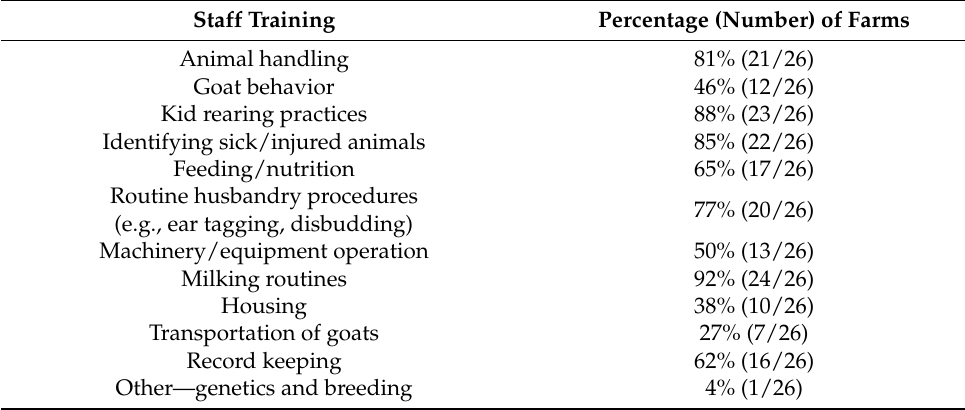
Table 1. Type of staff training provided by dairy goat producers.